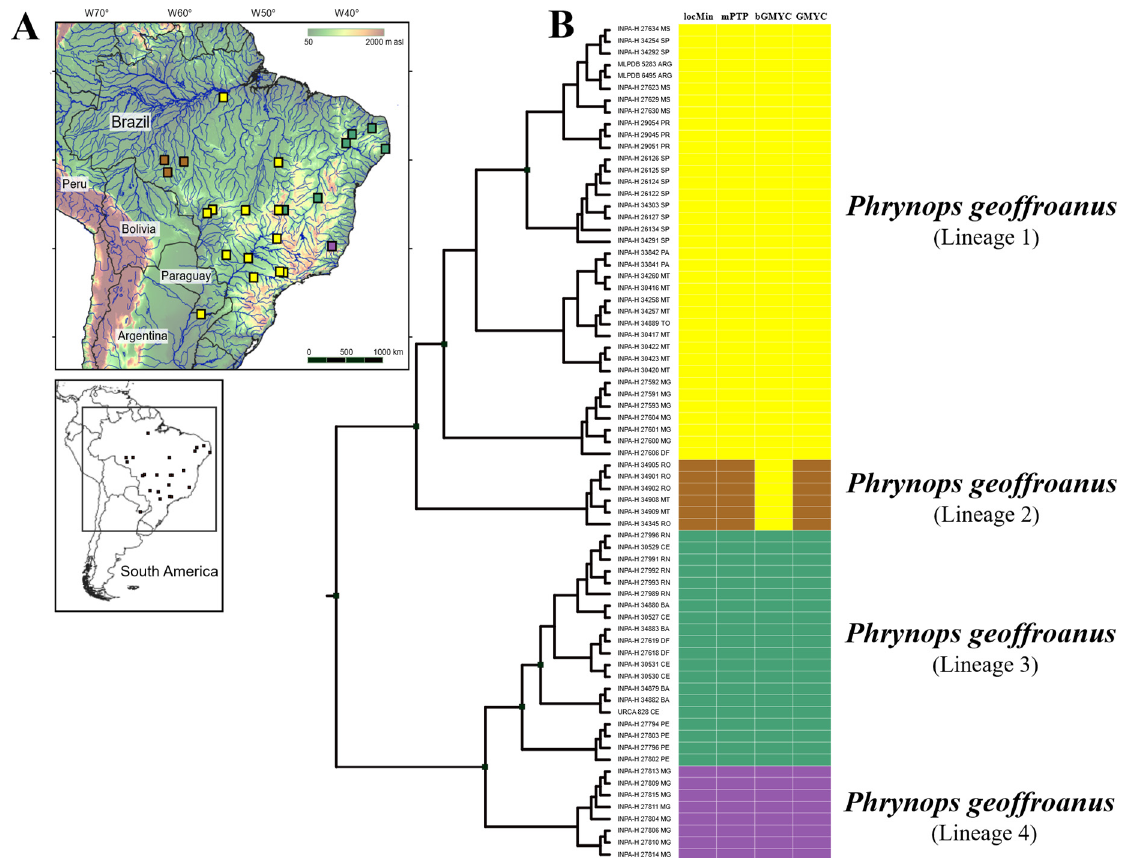
Figure 1. Patterns of genetic divergence in Phrynops geoffroanus estimated by four Bayesian methods of species discovery analysis. ( A ) Geographic distribution of lineages. ( B ) Maximum clade credibility chronogram from 1000 posterior trees generated using BEAST. Point estimate species delimitations are shown by method as colored boxes. Symbols and colors represent the same lineages in maps and trees. Phylogenetic relationships were based on Bayesian inference inferred from 1843 aligned sites of the 16S, Cytb, and COI mtDNA